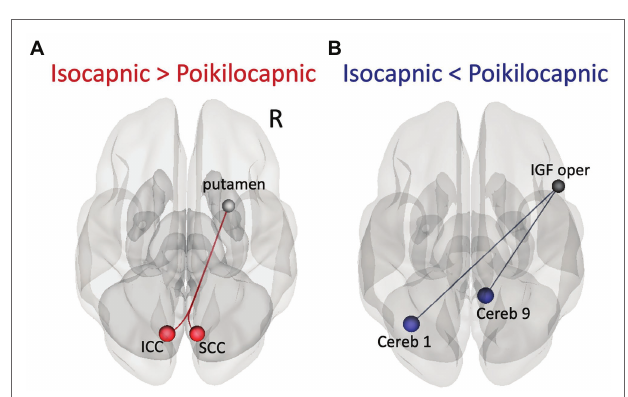
FIGURE 3 | ROI-to-ROI functional connectivity results. (A) Superior axial view of significantly increased functional connectivity in the isocapnic condition (when P ET CO 2 was kept constant) compared to the poikilocapnic condition (when P ET CO 2 was free to change) between the right putamen ROI seed and left intracalcarine cortex (ICC) and right supracalcarine cortex (SCC). (B) Superior axial view of significantly increased functional connectivity in the poikilocapnic condition compared to the isocapnic condition between the right opercular part of the inferior frontal gyrus (IFG) seed and left Cerebellum region 1 and right Cerebellum region